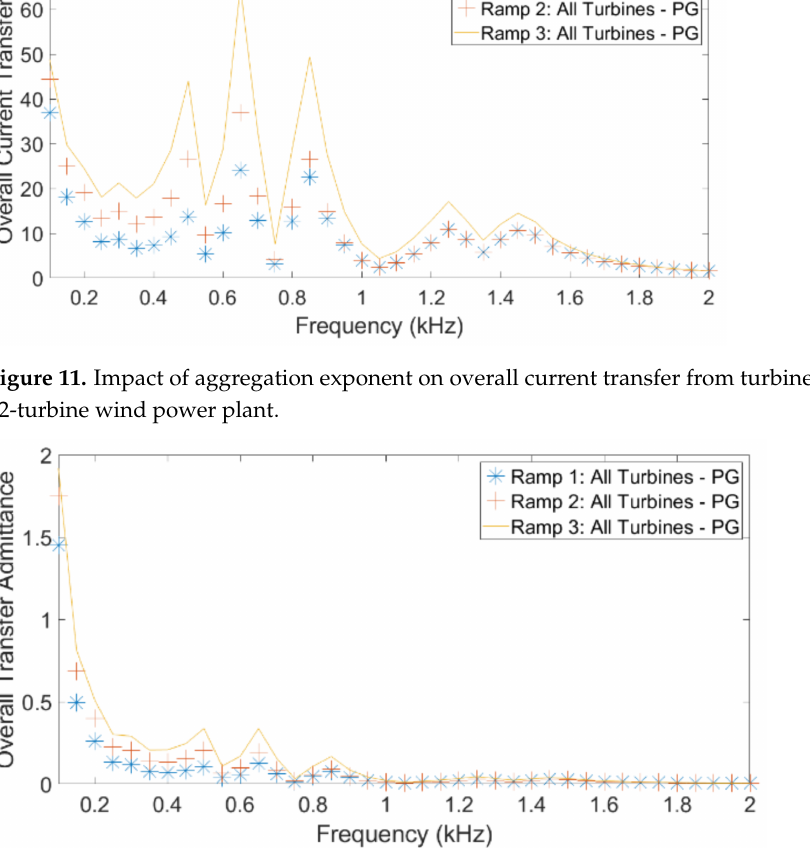
Figure 12. Impact of aggregation exponent on overall transfer admittance from turbines to public grid: 42-turbine wind power plant.